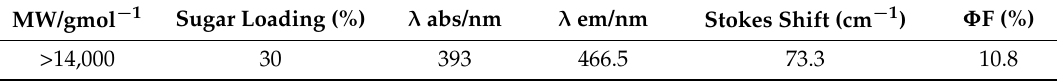
Table 1. Representative photophysical data of polymer